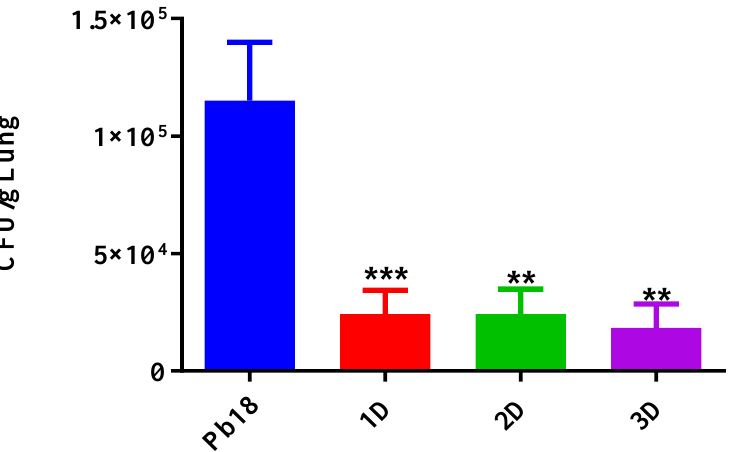
Figure 9. CFU of the lungs 51 days post infection. The P10 complexed nanoparticles significantly